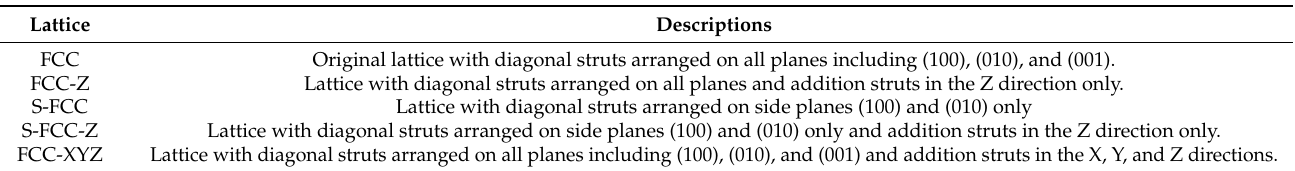
Figure 2. Specimens with lattice structure ( a ) lattice strut’s dimension, ( b ) compression specimen, ( c ) tensile specimen, ( d ) three-point flexural specimen dimensions, and ( e ) loading directions. Table 2. Description of the lattices.